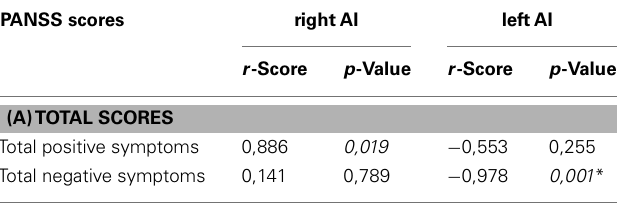
Table 7 | Partial correlations between intra-iFC in the right/leftAI within the SN and severity of positive and negative symptoms in patients with schizophrenia in state of remission.